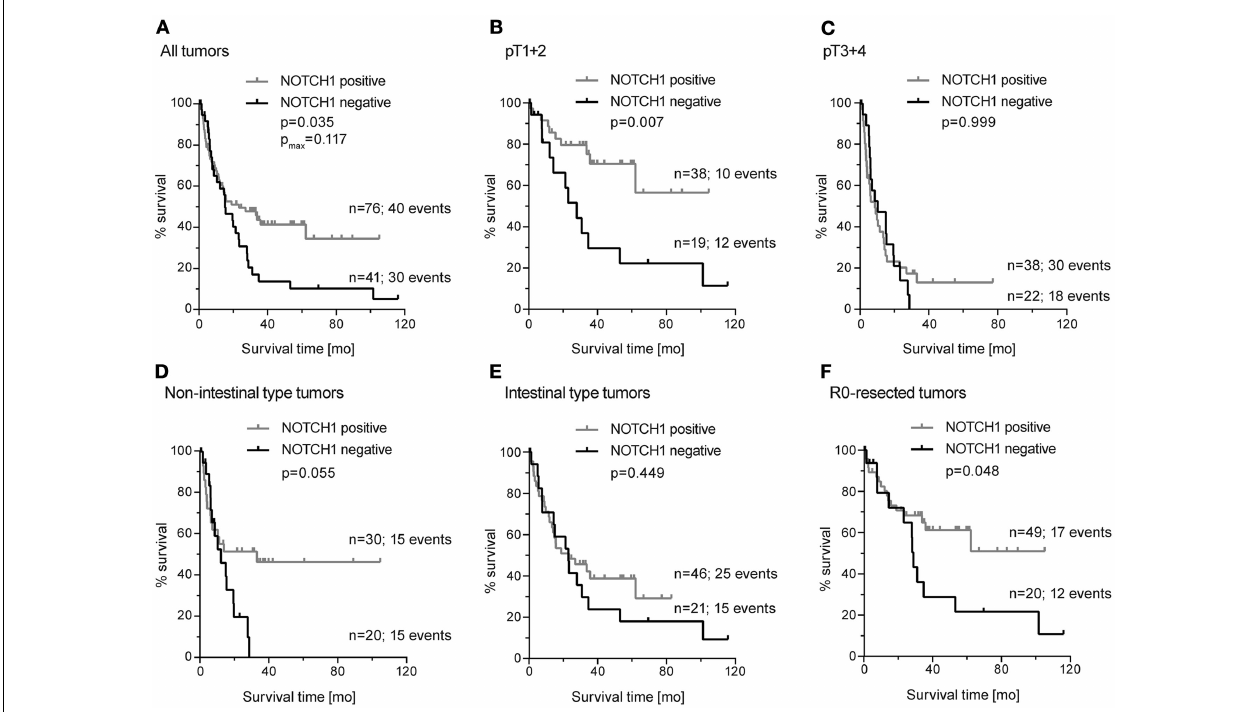
tumors (median OS: 12.2months; 95% CI 4.1–20.2 versus 33.2months; 95% CI not applicable); (E) subgroup of intestinal-type tumors (median OS: 23.1months; 95% CI 12.0–34.2 versus 23.3months; 95% CI 3.0–43.6); (F) subgroup of patients with completely resected tumors (R0) (median OS: 28.8months; 95% CI 27.1–30.5 versus median OS not reached); p -values were determined by log-rank statistics; p max. corresponds to p -values for maximally selected